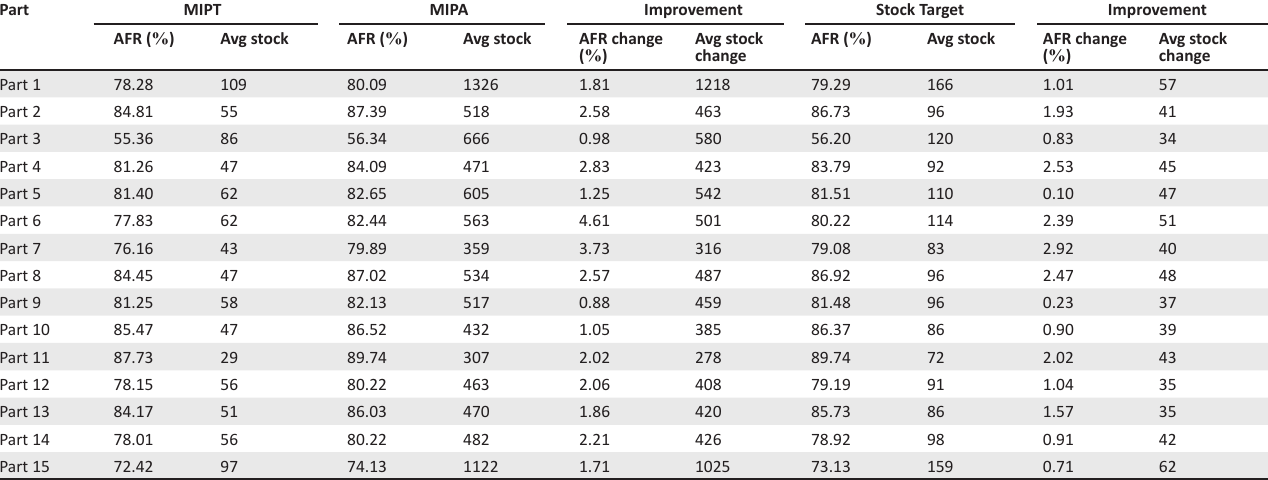
TABLE 7: Results of simulating actual demand data for erratic moving local parts. Part